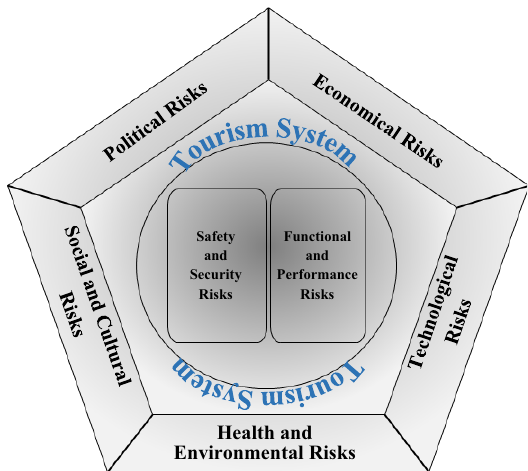
Fig. 2. Dimensions and components consolidated of risk management approach with tourism system theory in